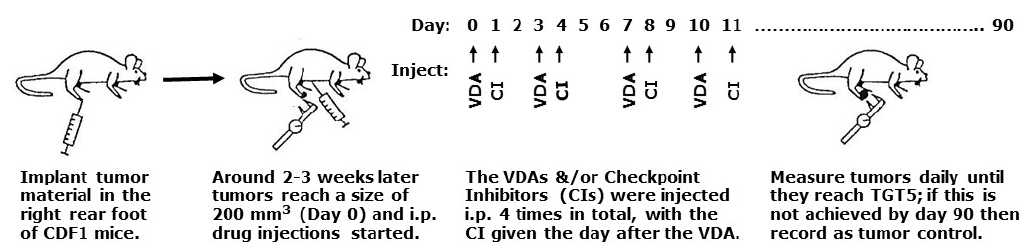
Figure 5. Schematic illustration of the overall experimental design.